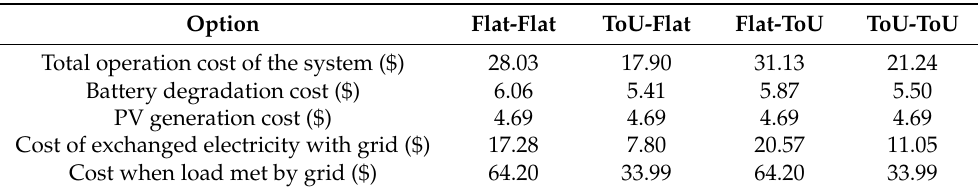
Table 6. Key performance indicators (KPIs) for comparison of economic analysis of the proposed EMSs for one week in winter under four options. Option Flat-Flat ToU-Flat Flat-ToU Total operation cost of the system